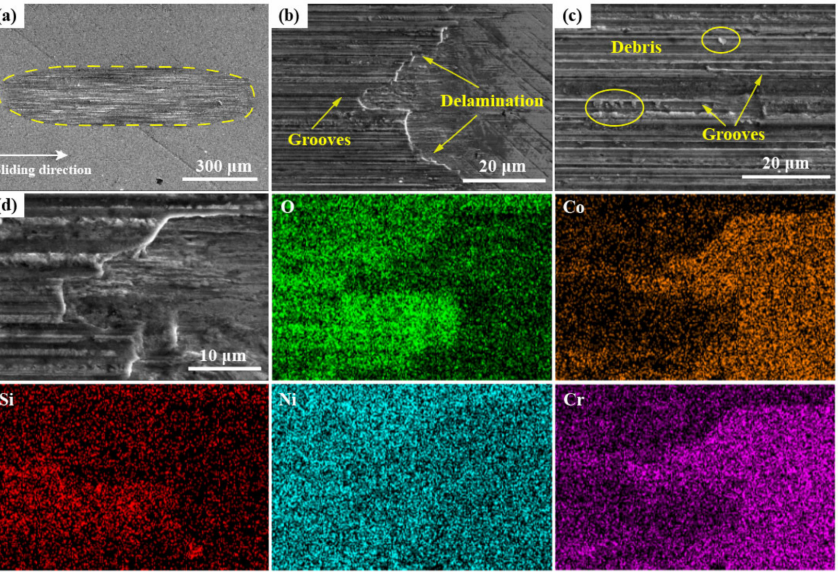
Figure 9. SEM and EDS micrographs of overall morphology ( a ) and some details ( b - d ) of the wear track for CoCrNi tested at